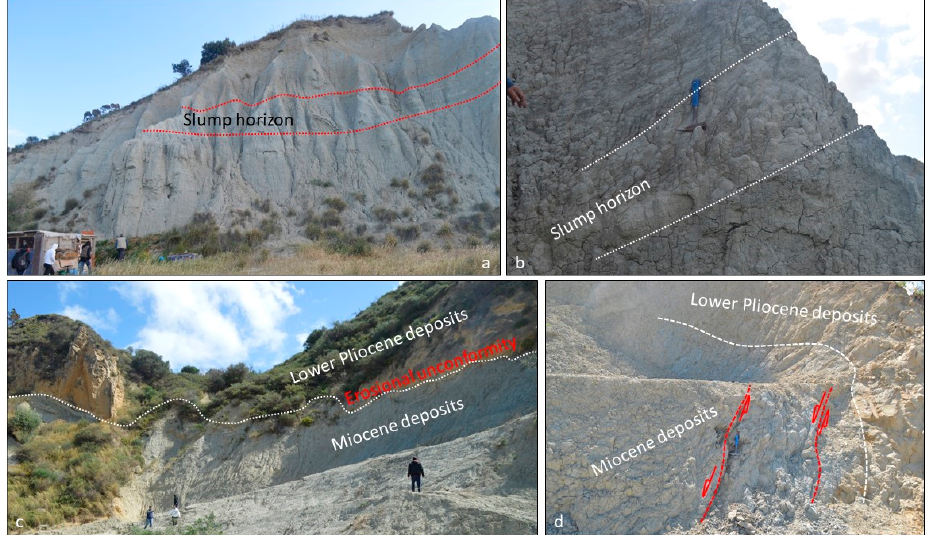
Figure 7. ( a , b ) The slump horizon within the lower Pliocene deposits close to the Zakynthos town. ( c , d ). The contact between upper Miocene and lower Pliocene deposits with either erosional contact or fault-controlled. See the absence of Messinian evaporites. For the position, see Figure 1c.